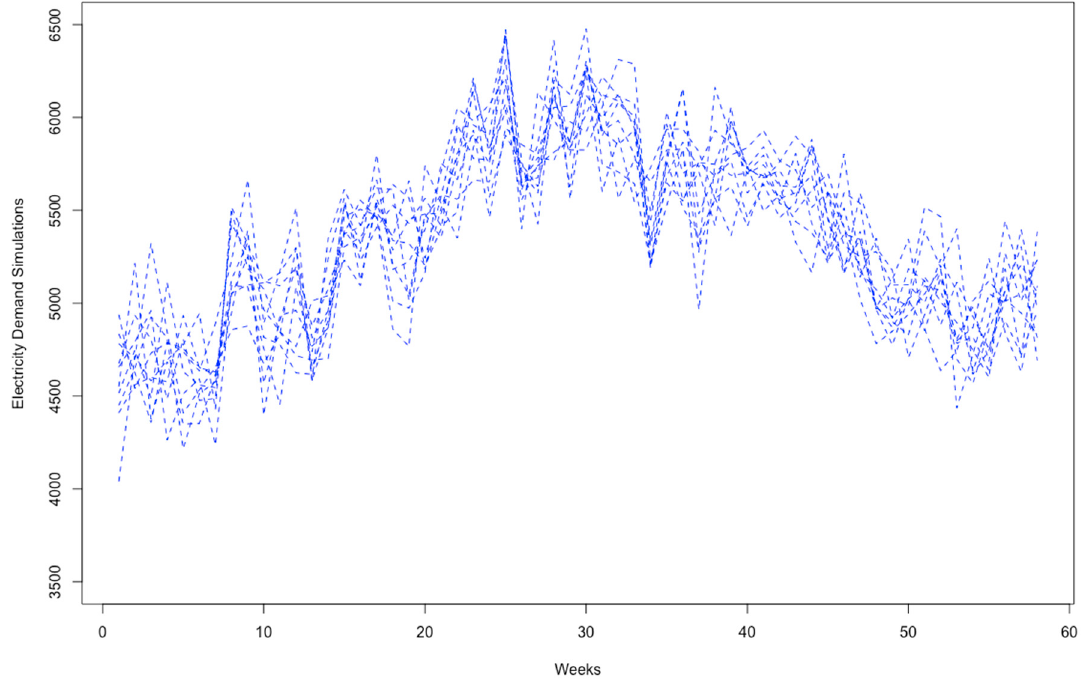
Figure 8. Weekly electricity demand simulations with GAM.